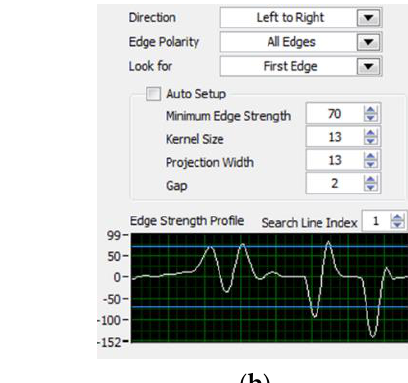
Figure 2. Flowchart of vehicle target recognition scheme.